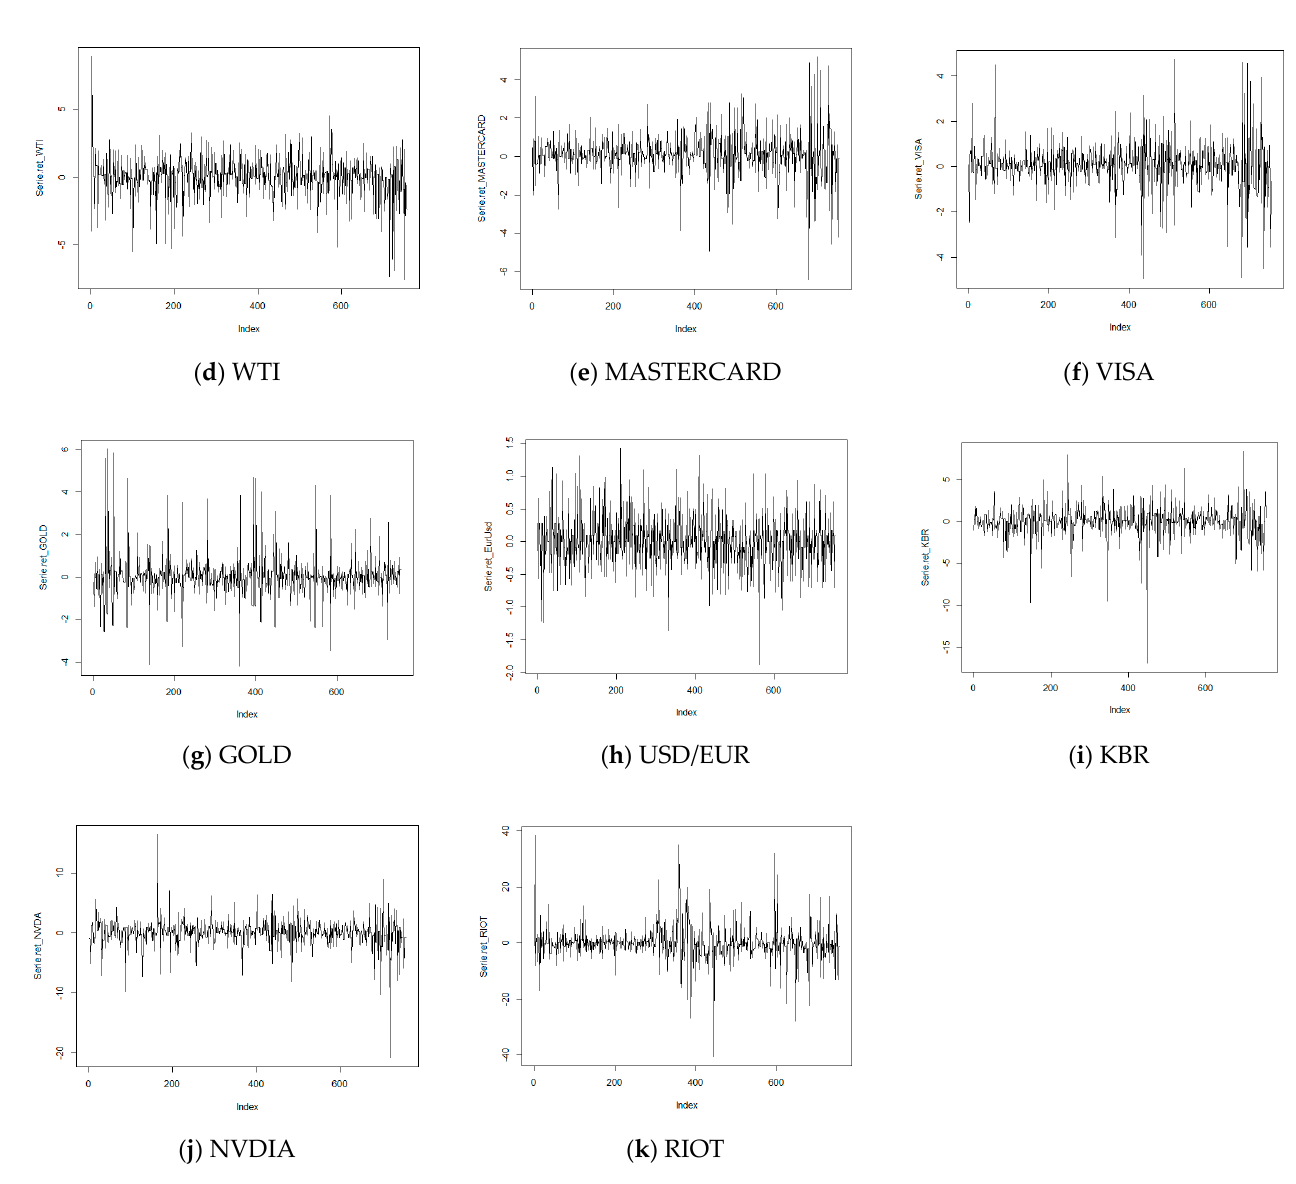
Figure 1. Time series plot of volatility data.